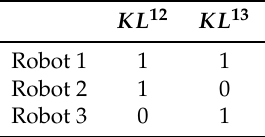
Table 2. The simplified signature matrix of robot 1.